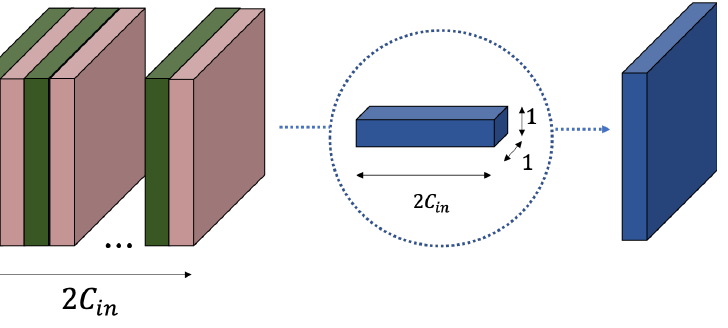
Figure 4. The second step of 2D convolution decomposition. In this step 1 × 1 convolution is applied to generate the final output